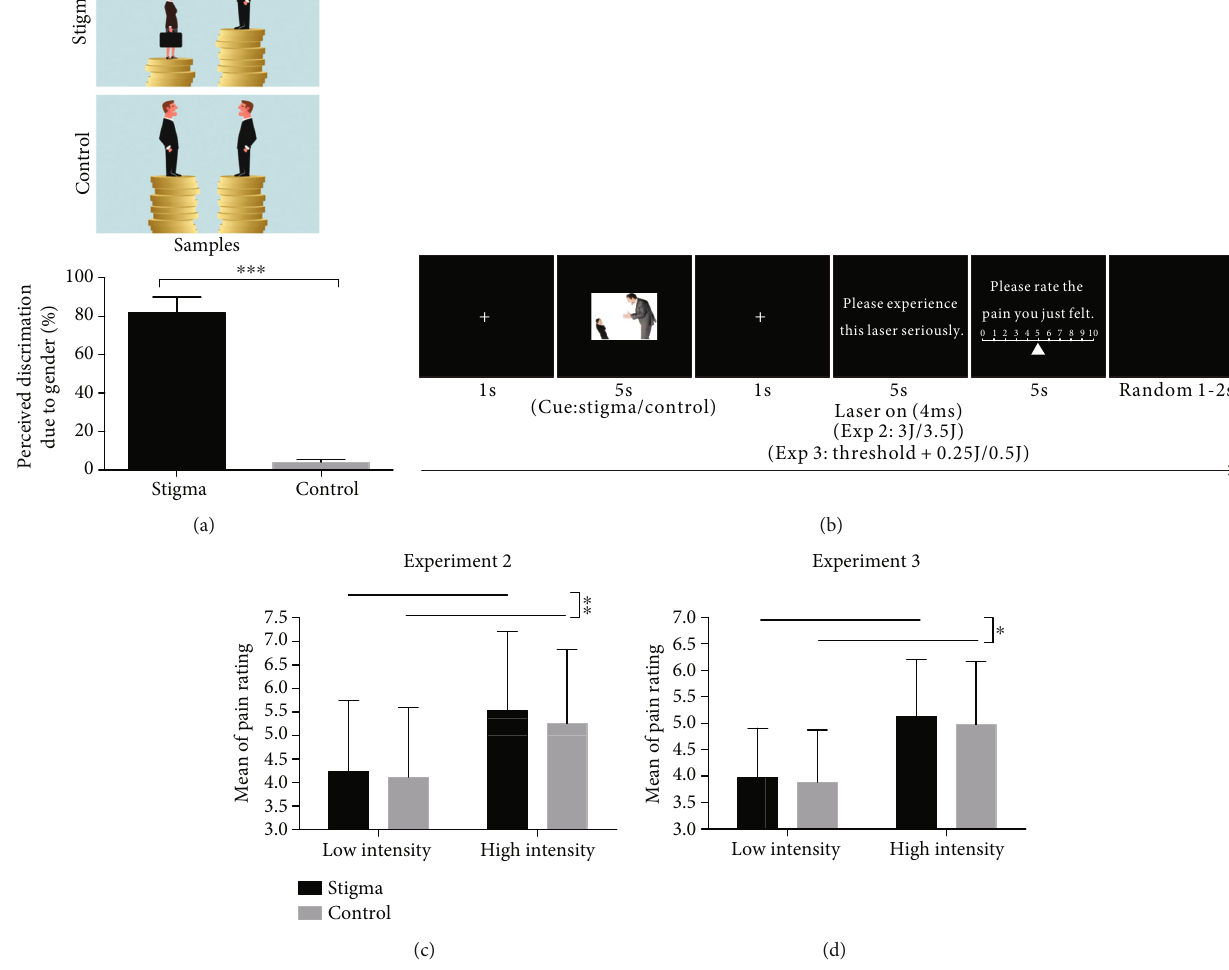
Figure 2: Experimental design and behavioral results in Experiments 2 and 3. (a) The material samples used in Experiment 2 and the results of stimulation assessment. (b) The experimental setup used in Experiments 2 and 3. (c) The e ff ect of condition on ratings of pain intensity in Experiment 2. (d) The e ff ect of condition on ratings of pain intensity in Experiment 3. ( ∗∗∗ p < : 001 , ∗∗ p < : 01 , and ∗ p < : 05